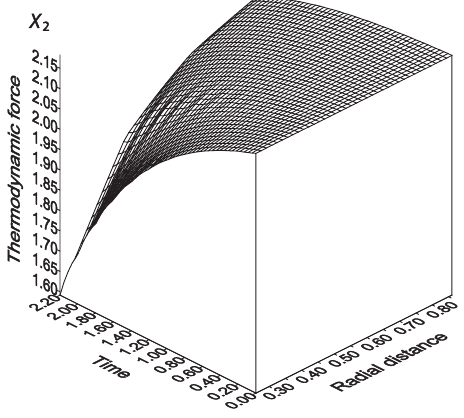
Figure 4.9 . Variation of the thermodynamic force X distance and time.